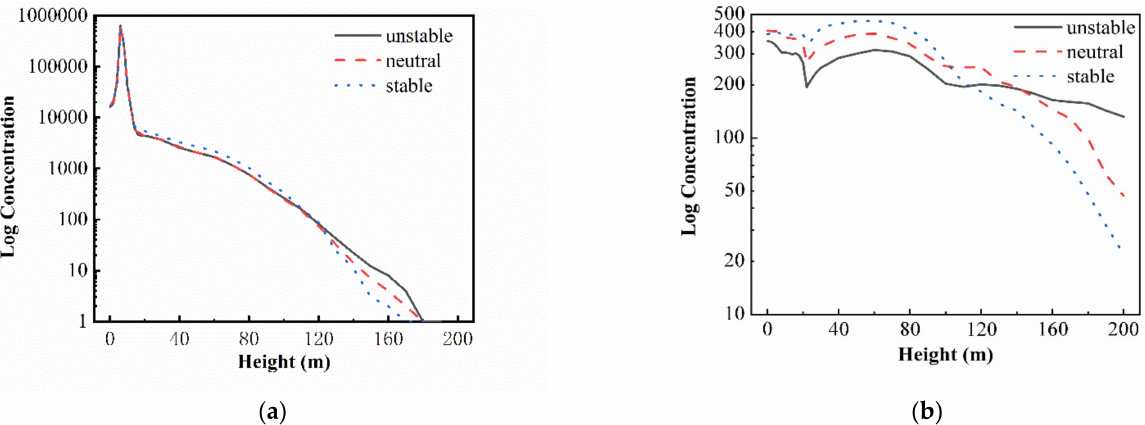
Figure 12. The maximum concentration of SF 6 at different altitudes:( a ) 20:08 LST; ( b ) 20:40